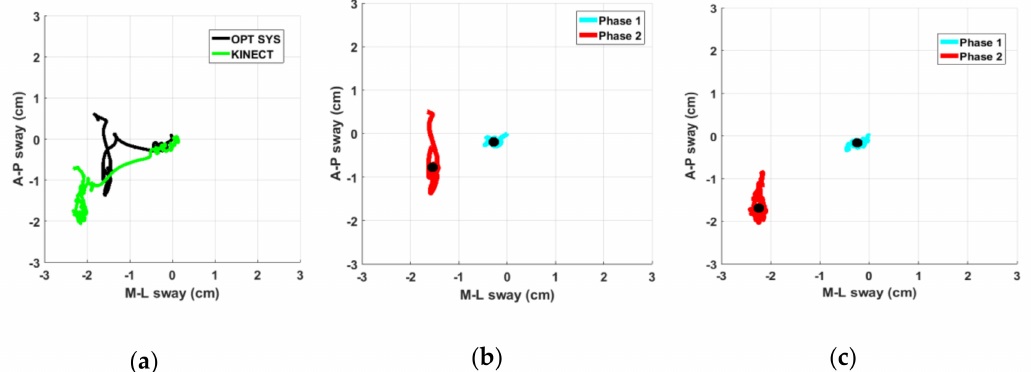
Figure 9. ( a ) Example of CoM trajectory of a PD subject represented in the Antero-Posterior (AP) and Medio-Lateral (ML) components during the Po task, as measured by our system (green line) and by optoelectronic system (black line); ( b ) Details of the trajectories during the first (cyan line) and second phase (red line) of PS COM task with the respective centroids (black dots) as measured by optoelectronic system; and ( c ) as measured at the same time by our